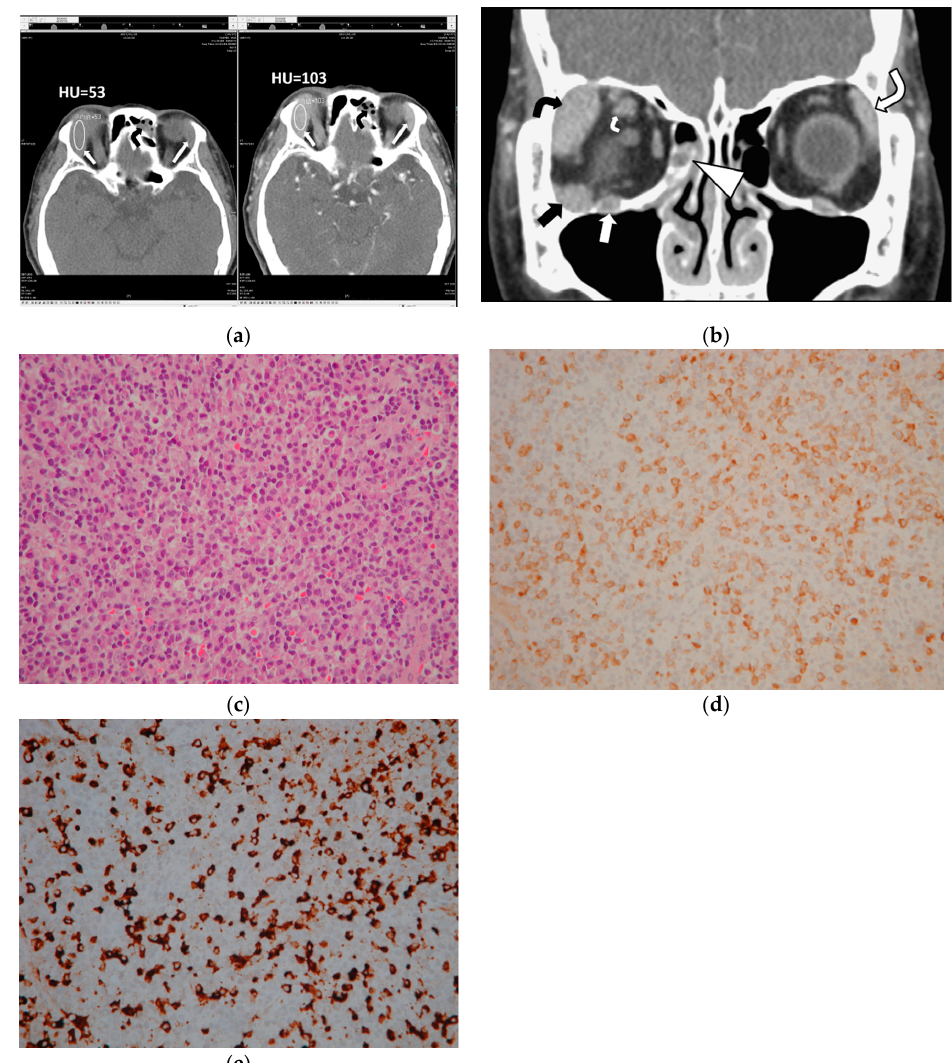
Figure 1. A 68-year-old man with immunoglobulin G4 (IgG4)-related orbital disease (IgG4-ROD) shows multiple tumors in bilateral orbital cavities. ( a ) Axial computed tomography (CT) scans show masses in bilateral lacrimal glands (short and large arrows). The mean value of CT Hounsfield unit scale (CTHU) is measured at the enlarged right lacrimal gland (short arrows) on a picture archiving and communication system monitor. The region of interest (ROI) marker in an oval shape is placed in the center of the mass (short arrows) to cover 50% of the largest tumor area. The mean value of precontrast CTHU is 53 and that of postcontrast CTHU is 103. Sinusitis is found in the left frontal sinus with mucus retention (black curved arrows); ( b ) Coronal postcontrast CT scan shows multiple masses or enlargement in various ophthalmic tissues with regular borders and homogeneous contrast enhancement in bilateral orbital cavities as follows: a mass at the extraconal compartment of the right orbital cavity (black arrow),the right lacrimal gland (black curved arrow), the left lacrimal gland (large white curve arrow), the right superior rectus muscle belly (small white curve arrow) and the right infraorbital nerve (white arrow). Sinusitis is noted in the right ethmoid sinus with mucus retention (arrowhead); ( c ) Pathologic specimen shows infiltration of many lymphoplasma cells and mild fibrosis (hematoxylin–eosin stain, original magnification ×200); ( d ) Immunostaining for immunoglobulin G (IgG)-expression shows many plasma cells are positive for IgG stains (original magnification 200); × ( e ) Immunostaining for IgG4-expression shows abundant IgG4-positive plasma cells have infiltrated the lesion. IgG4-postive / IgG-positive plasma cell ratio is more than 40%. There are more than 100 IgG4-positive plasma cells in one high-powered field ( > 100 / HPF) (original magnification ×